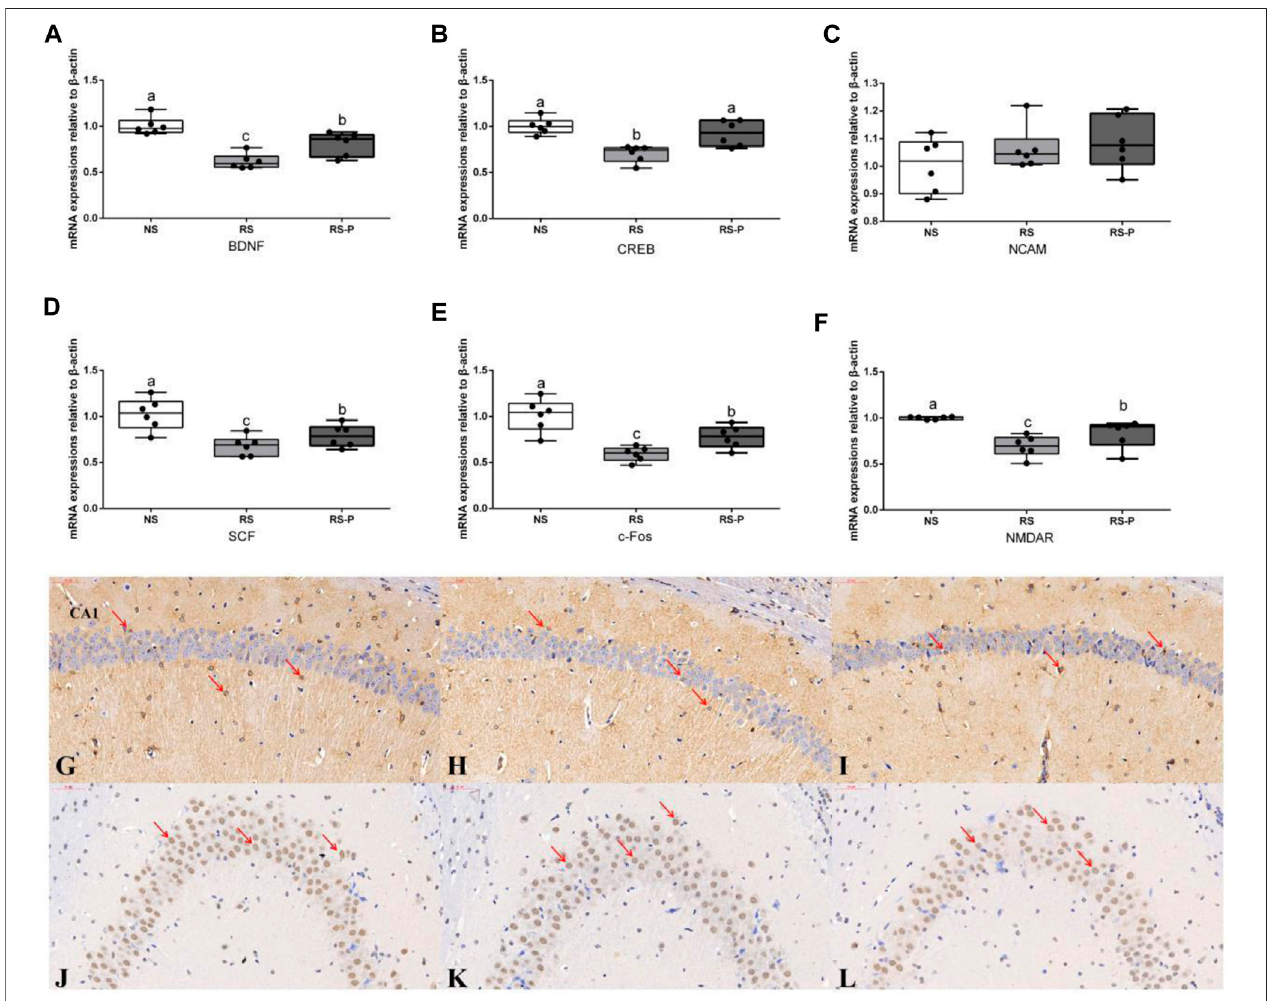
FIGURE 6 | Expression levels of memory-related functional proteins in the hippocampus. (A) – (F) : Relative expression of BDNF, CREB, NCAM, SCF, c-Fos, and NMDAR, respectively. Data are presented with the means ± standard deviation ( n (cid:2) 6). Bars with different letters are signi fi cantly different on the basis of Duncan ’ s multiple range test ( P < 0.05). (G) – (I) Immunohistochemistry of BDNF expressions in the hippocampus of NS (G) , RS (H) and RS-P (I) groups. (J) – (L) Immunohistochemistry of CREB expressions in the hippocampus of NS (J) , RS (K) and RS-P (L) groups. The BDNF- and CREB-positive cells are brown like the arrowindication,themagni fi cationofallthe fi guresare40 × .BDNF,brain-derivedneurotrophicfactor;CREB,cyclicampresponseelementbindingprotein;NCAM,neural cell adhesion molecule; SCF, stem cell factor; NMDAR, N -methyl-D-aspartate receptor.